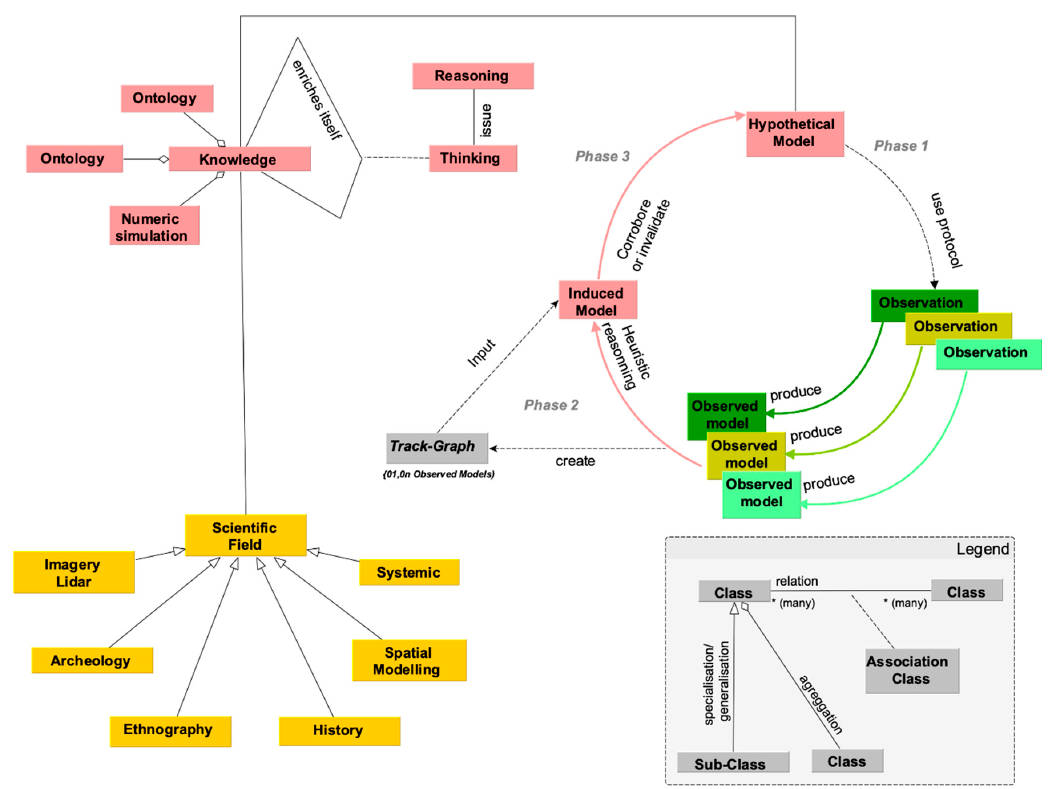
Figure 10. The role of ontologies and the track graph in knowledge creation.